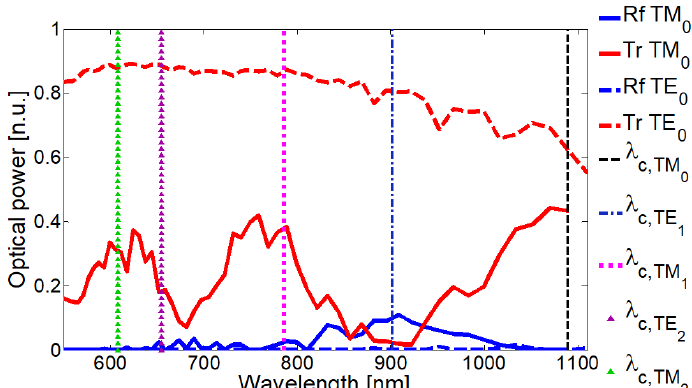
Figure 5. Polarization dependence of transmitted signal. For TM 0 mode (vertical polarization), the normalized transmission spectrum exhibits two broad deeps due to the excitation of modes in the hyperbolic metamaterial. For TE 0 mode (horizontal polarization), no deeps are observed as no SPP are excited in the metamaterial.